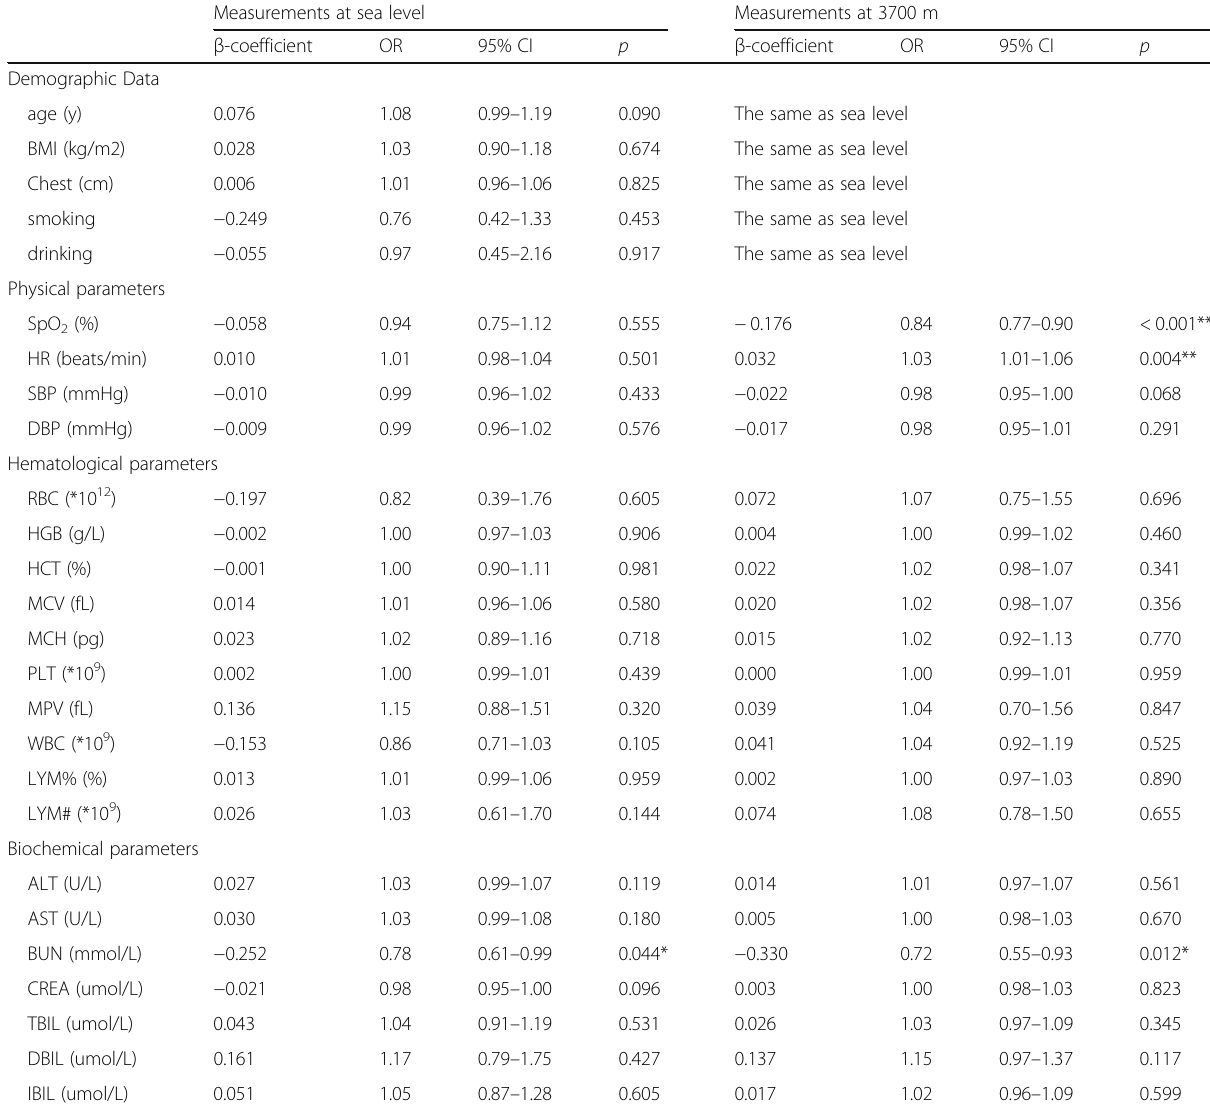
Table 4 Univariate logistic regression for each measurements at sea level and 3700 m ( N = 318) Measurements at sea